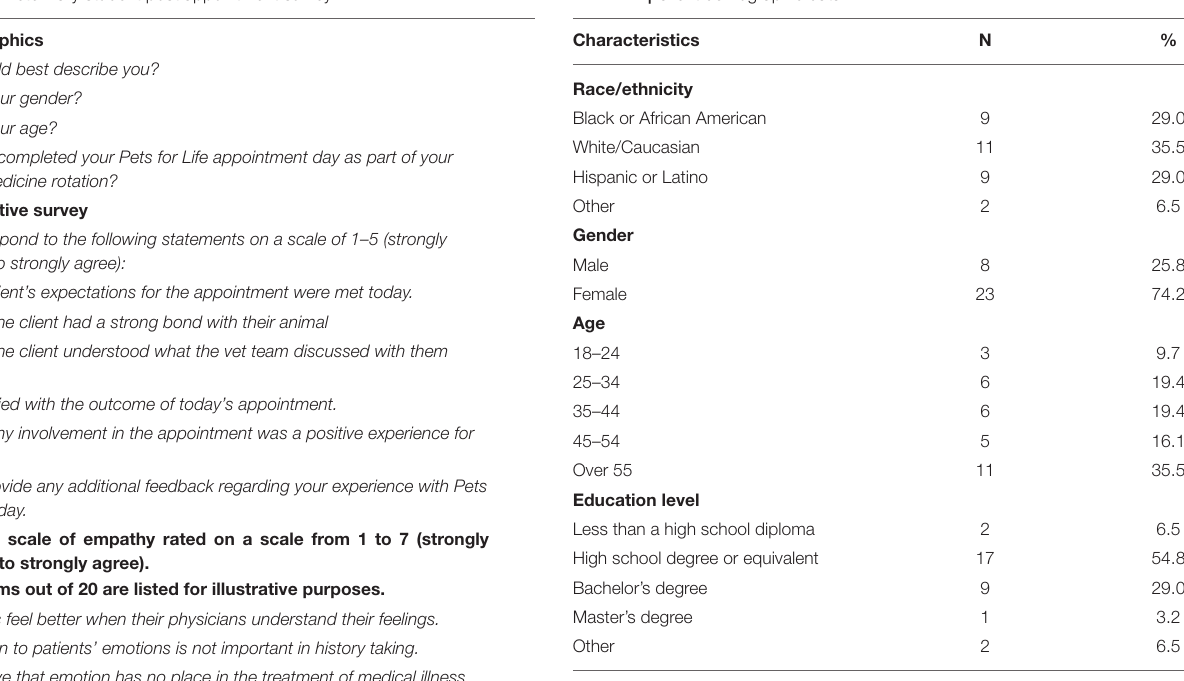
TABLE 3 | Veterinary student post appointment